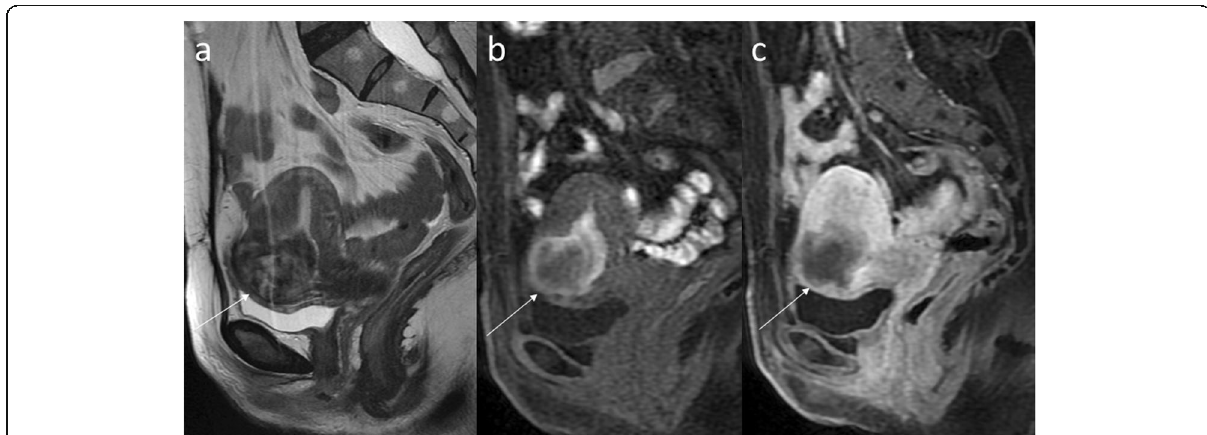
Fig. 12 Pelvic MRI in the sagittal plane, FSE/T2WI ( a ). Dynamic contrast-enhanced fat-saturated T1 sequence before ( b ) and after ( c ) gadolinium administration. Retained products of conception (RPOC) of mixed signal intensity in the C-section niche after treatment with potassium chloride and methotrexate